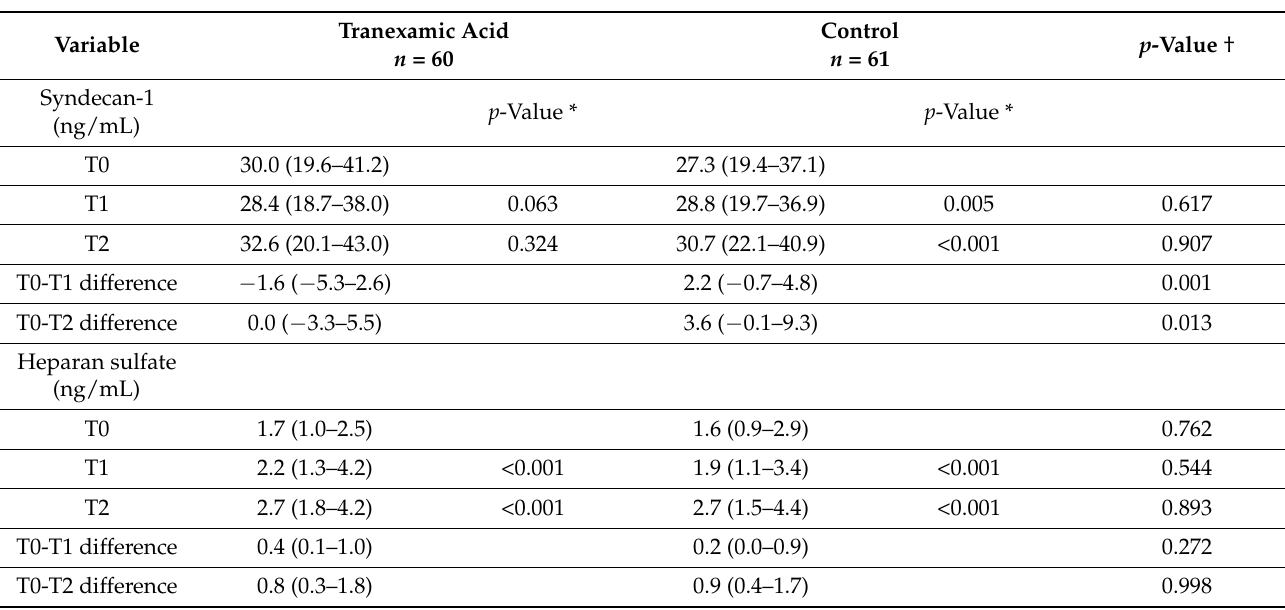
Table 3. Perioperative serum concentration of syndecan-1 and heparan